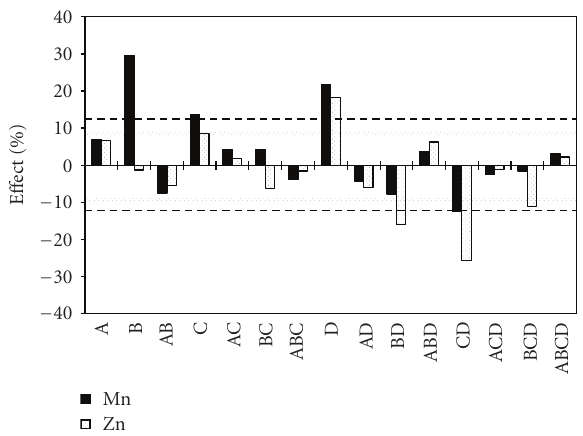
Figure 4: E ff ect of most significant factors and of their interactions on Mn and Zn extraction yield at 5 h (A: sulphuric acid concentra- tion; B: citric acid concentration; C: temperature; D: pulp density).